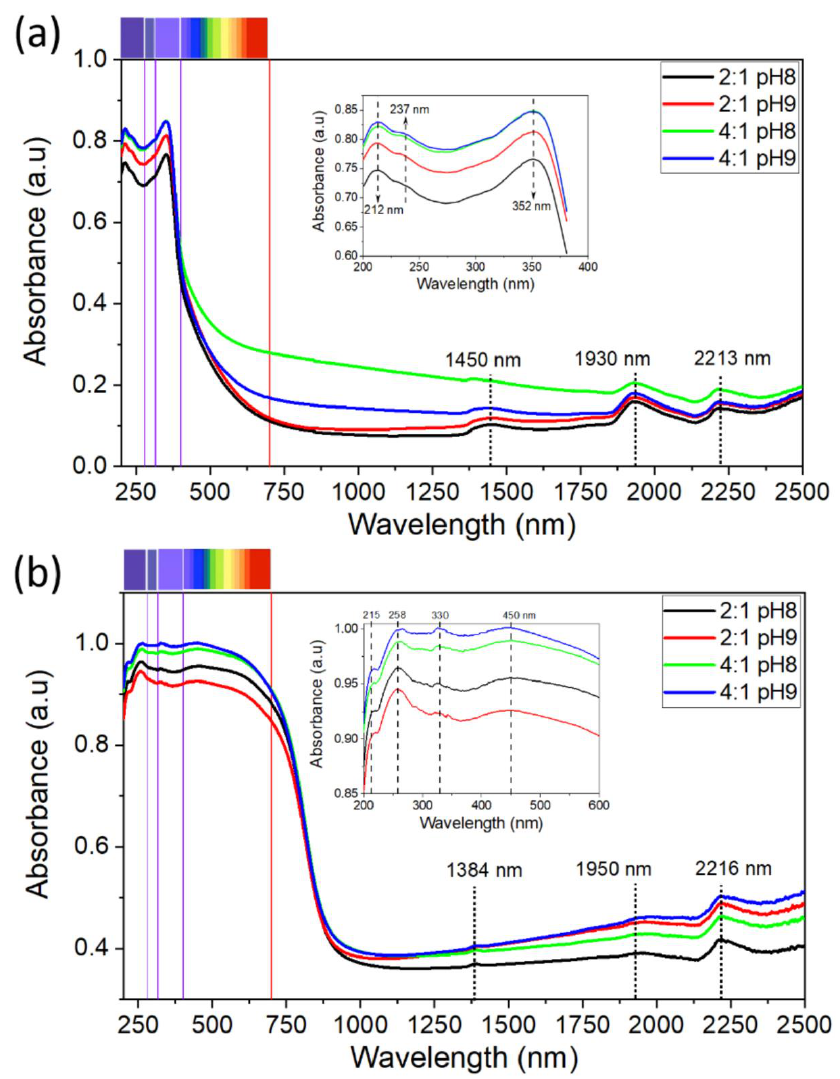
Figure 7. UV-Vis absorption spectra of the studied ( a ) TiO 2 and ( b ) CuO powders. The inset of each figure is a zoom-in of the spectra in the UV